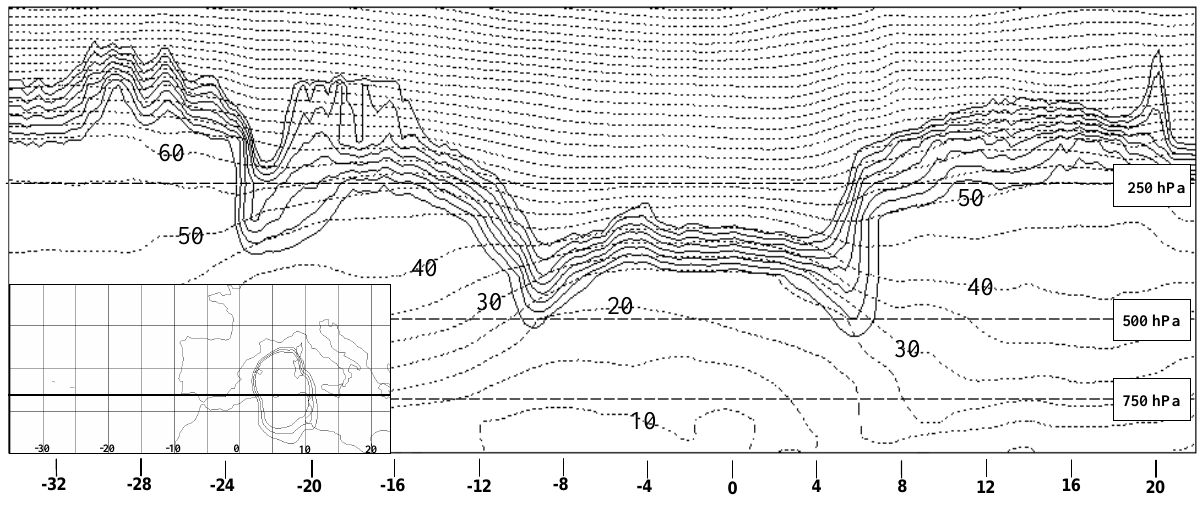
Fig. 15. NLH21–23 simulated PV (solid lines, PVU) and potential temperature (dashed lines, ◦ C) vertical section across the cyclone at 18:00UTC, 21December. PV isolines start at 1.5PVU with a 0.5PVU interval. Potential temperature isolines depicted with a 5 ◦ C interval. Left bottom map shows the vertical section position relative to the